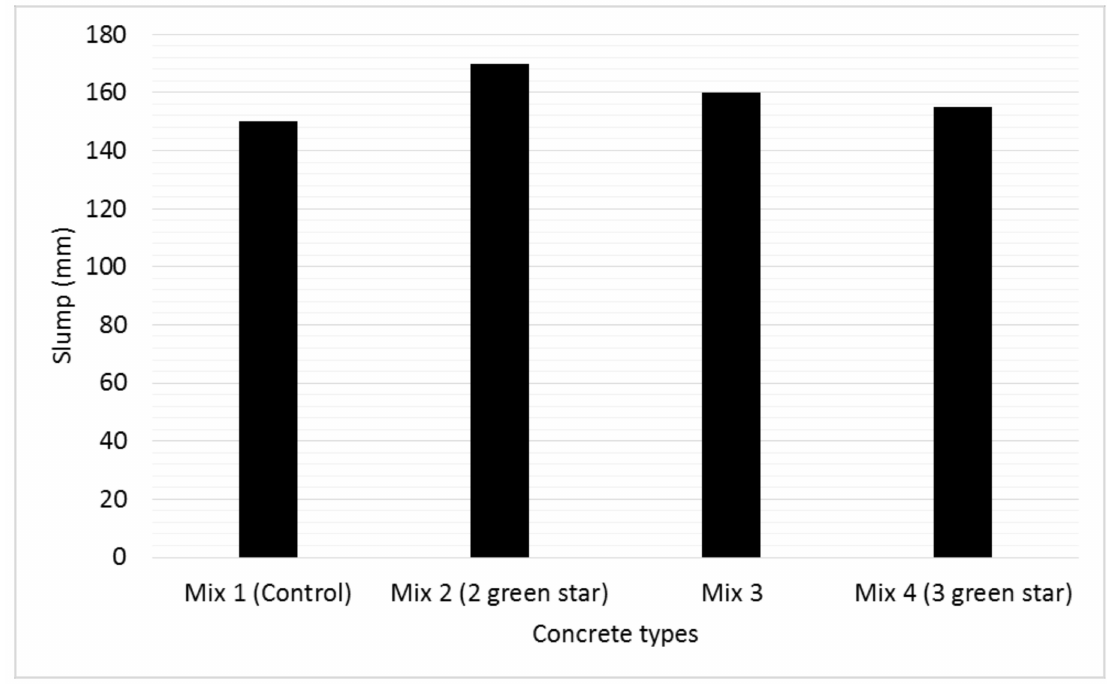
Figure 3. Measured slump values of green star concretes and control